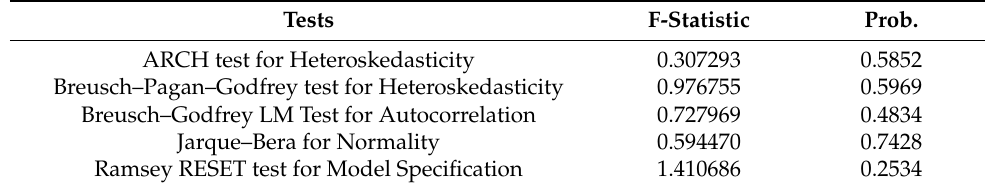
Figure 6. Dynamic Multiplier graph for LZERT.